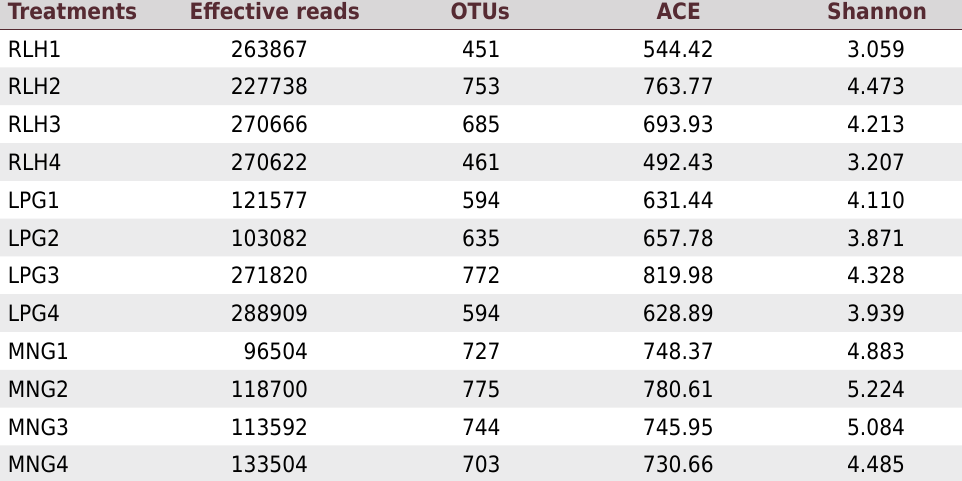
Table 3. Fungal diversity (Shannon) and richness (OTUs, ACE) of soil samples subjected to the following treatments: RLH, LPG, and MNG